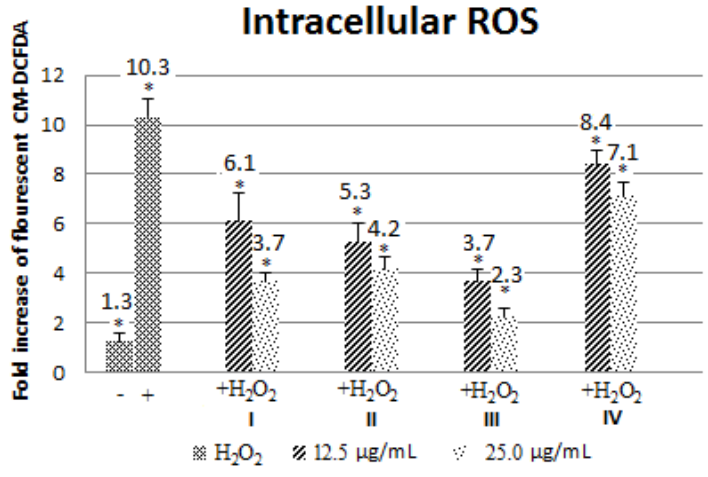
O -induced ROS production in β -TC6 cells pre-treated 2 2